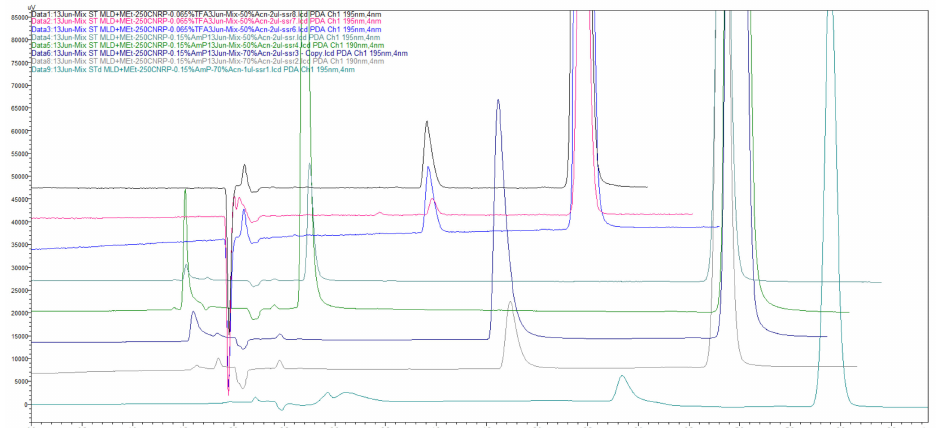
Figure 25. Overview of the retention map, testing Waters Spherisorb CNRP-250 × 4.6 mm, a final orientational overview of the behavior of these columns with different mobile phases, with the same organic solvent ACN but with different modifiers, can be seen and analyzed on the overlaid chromatograms.